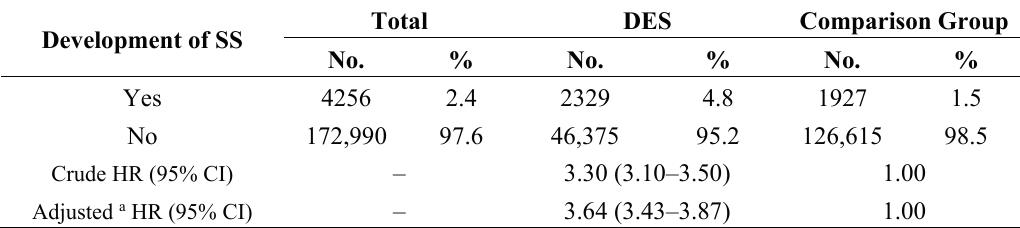
Table 2. Crude and adjusted hazard ratios for developing Sjögren’s syndrome (SS) among patients with dry eye syndrome (DES) and comparison group during 2000–2008